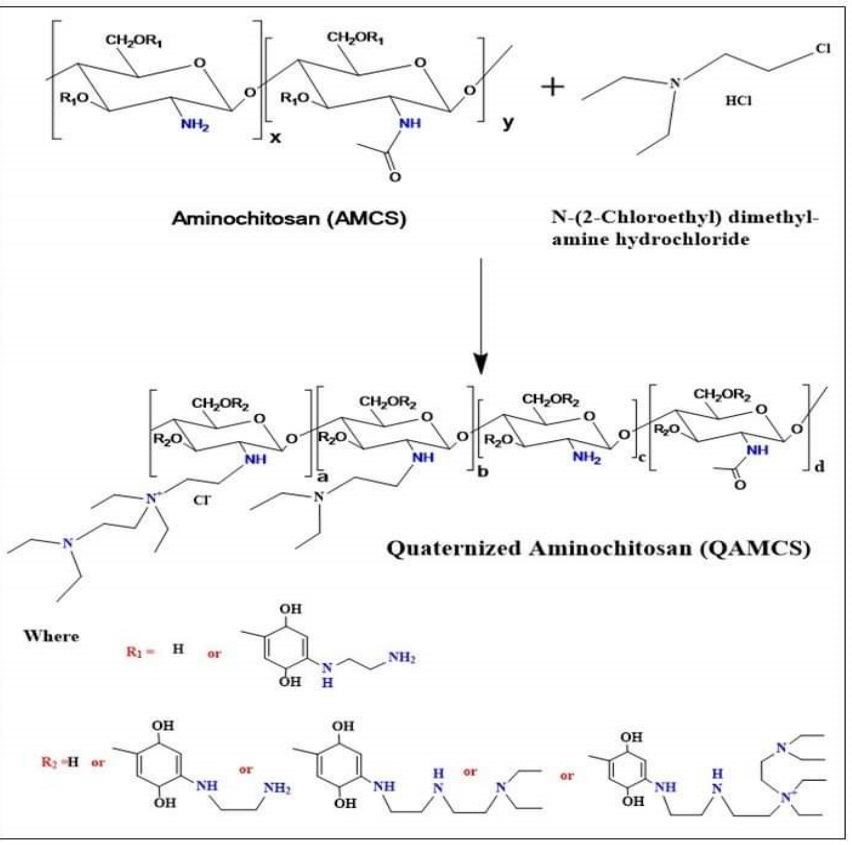
Figure 1. A schematic diagram for the synthesis of quaternized aminochitosan derivative.